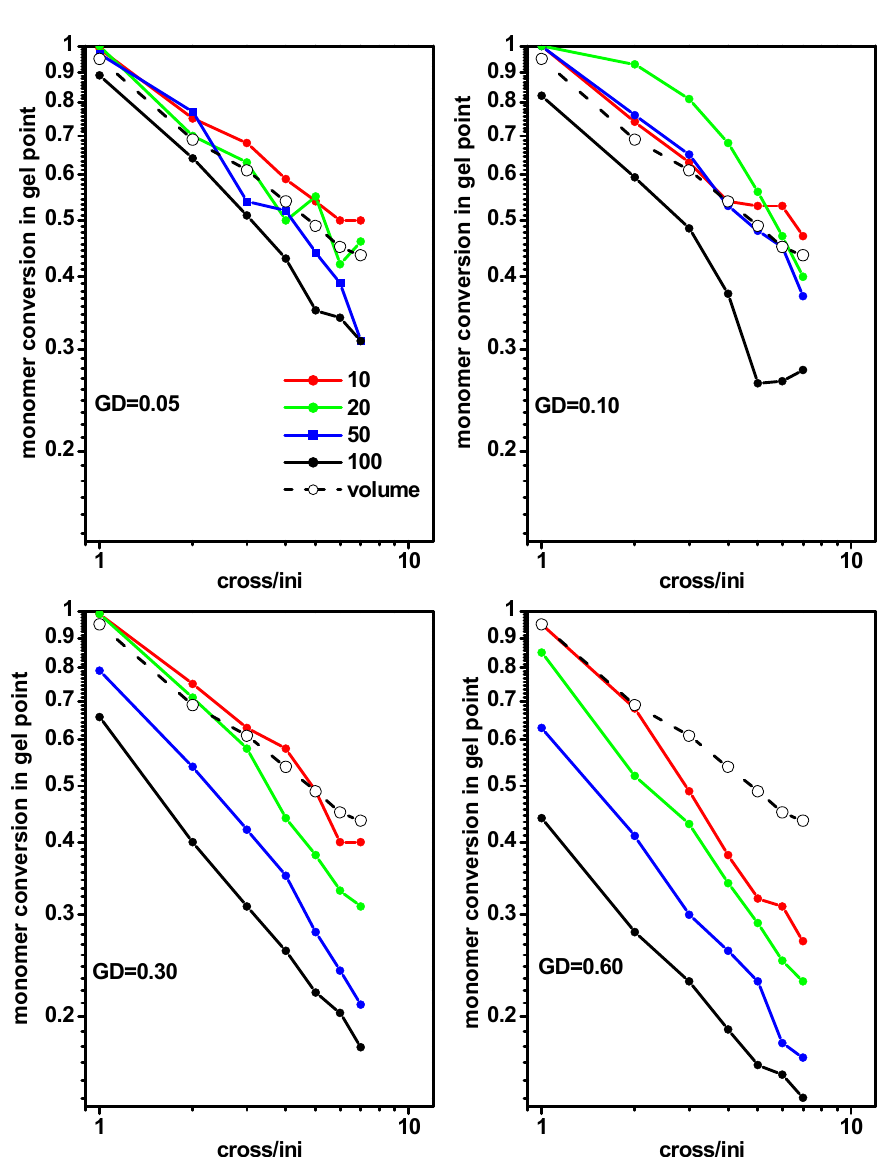
Figure 10. The conversion of monomer at the gel point for polymerization of grafted chains in a slit as a function of the ratio [Ini]/[X] for different grafting densities. The widths of the slit are given in the inset. The monomer conversion at gel point for a free volume are marked by the dashed line.